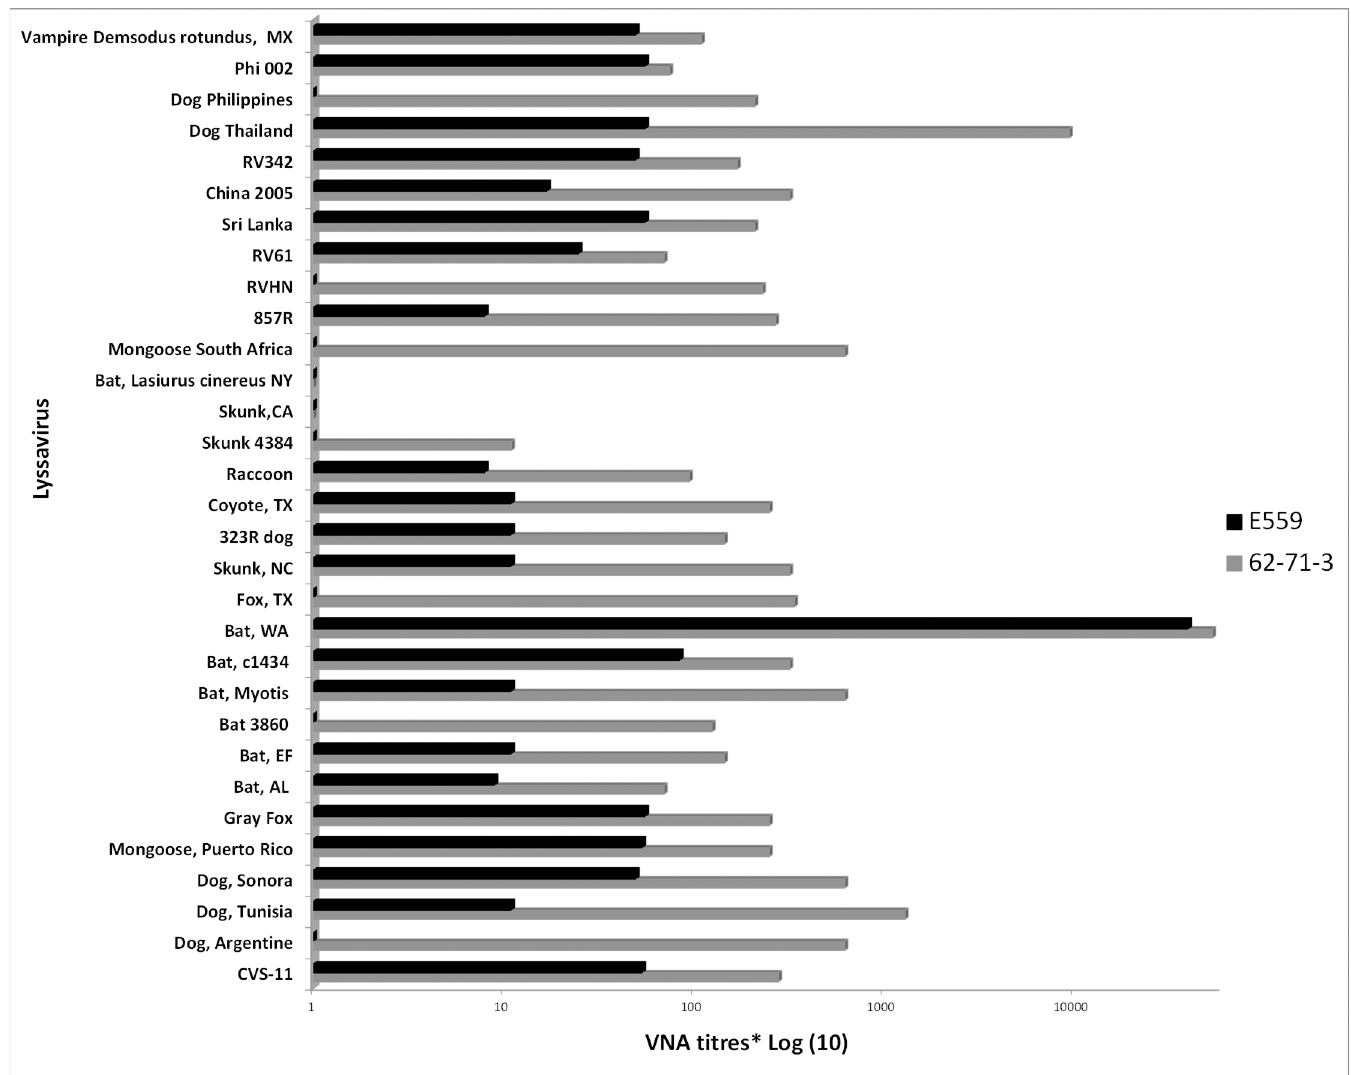
Fig 8. Graphic depiction of in vitro Rabies neutralisation activity of mAbs E559 and